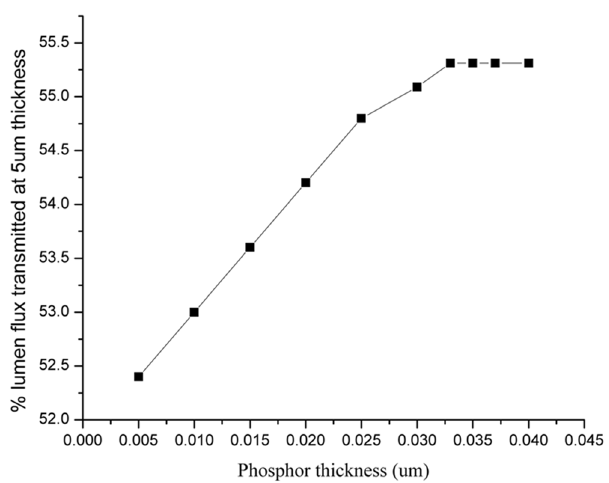
Figure 7. TracePro simulation of the % of blue light transmitted out of the phosphor layer with the phosphor thickness due to phosphor